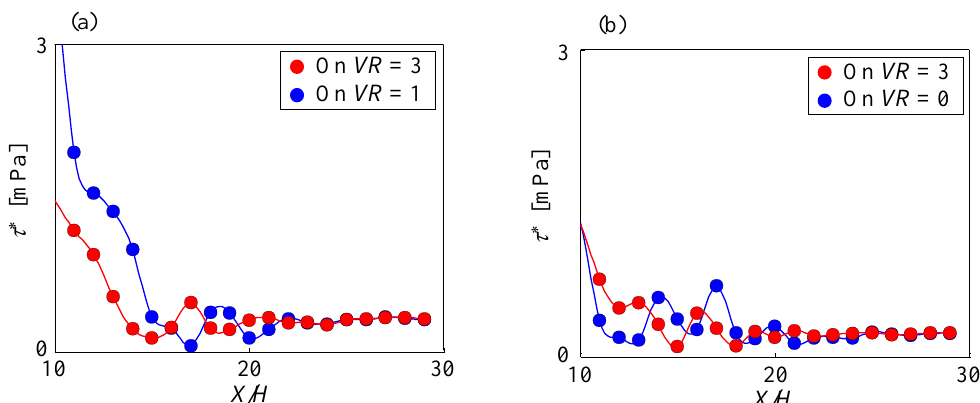
Fig. 15 Vortical strength of the transverse vortex   ) in the streamwise direction under Re = 900 and F = 150 Hz in (a) case 2 and (b) case 4. SJ